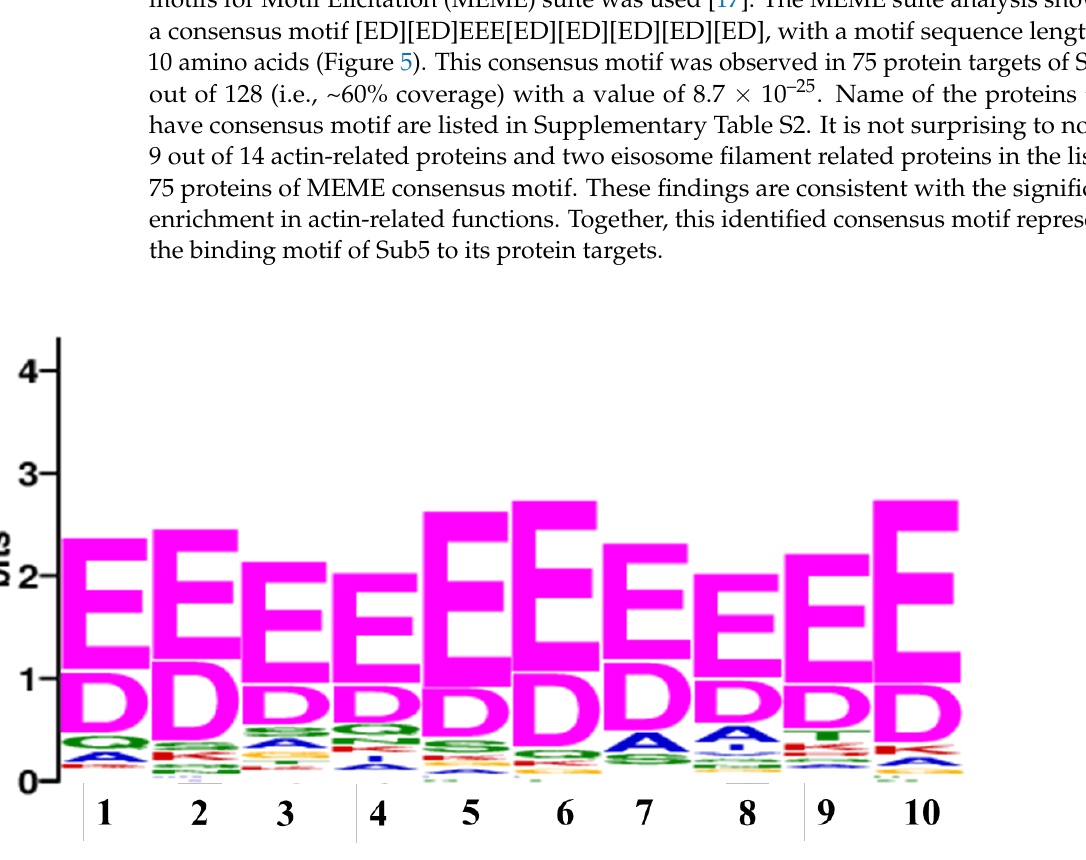
Figure 5. The consensus motif identified in protein targets of Sub-5. Using MEME, the consensus motif